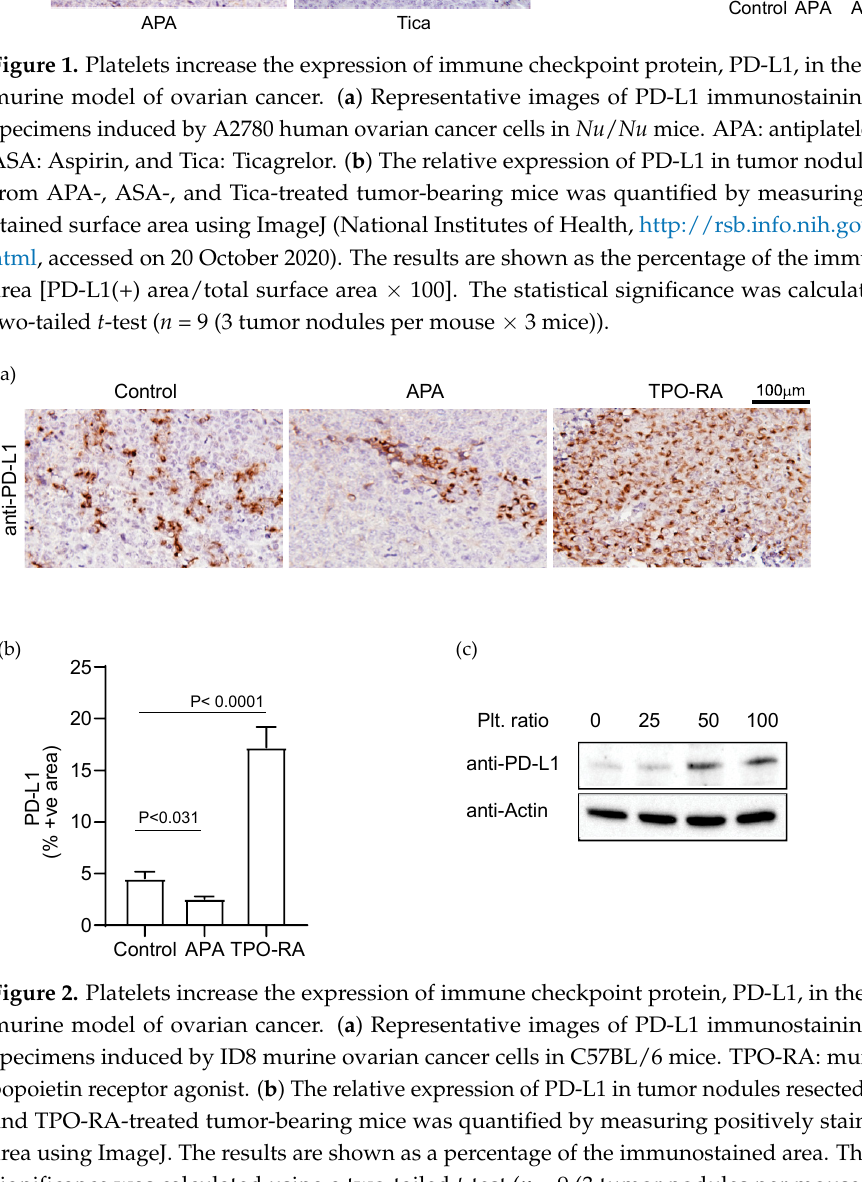
Figure 2. Platelets increase the expression of immune checkpoint protein, PD-L1, in the syngeneic murine model of ovarian cancer. ( a ) Representative images of PD-L1 immunostaining in tumor specimens induced by ID8 murine ovarian cancer cells in C57BL/6 mice. TPO-RA: murine thrombo- poietin receptor agonist. ( b ) The relative expression of PD-L1 in tumor nodules resected from APA- and TPO-RA-treated tumor-bearing mice was quantified by measuring positively stained surface area using ImageJ. The results are shown as a percentage of the immunostained area. The statistical significance was calculated using a two-tailed t -test ( n = 9 (3 tumor nodules per mouse × 3 mice)). ( c ) Western blot analysis of the expression of PD-L1 in ID8 cells at the baseline and after co-incubation with platelet at a ratio of 1:25, 1:50, and 1:100 (number of cancer cells: number of platelets). Western blot band representing β -Actin was used as a loading control. The data are representative of three independent experiments. For original blots, see Supplementary File